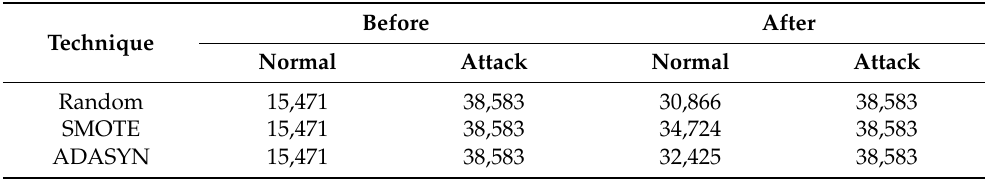
Table 7. Balancing Morris power dataset with oversampling.